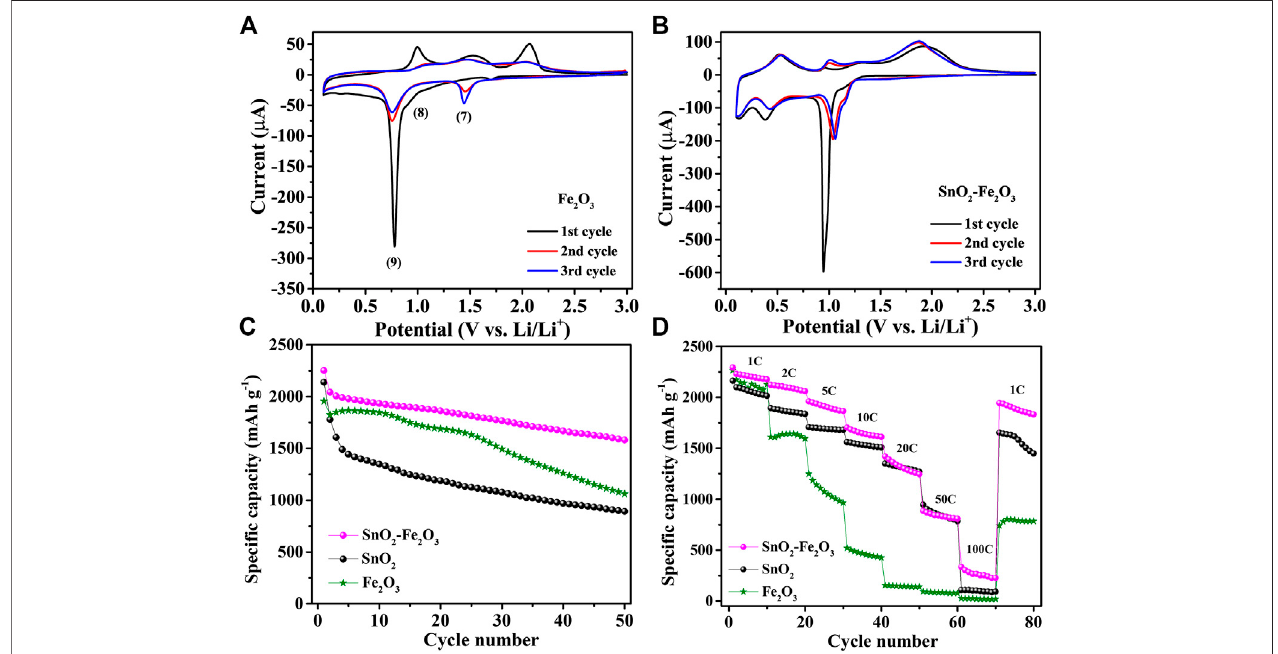
FIGURE5| CV curvesof (A) conversion-type Fe 2 O 3 and (B) SnO 2 – Fe 2 O 3 composite electrodes.The comparison ofSnO 2 ,Fe 2 O 3 and SnO 2 – Fe 2 O 3 electrode: (C) cycling performance at 1 C and (D) rate performance from 1 to 100 C.